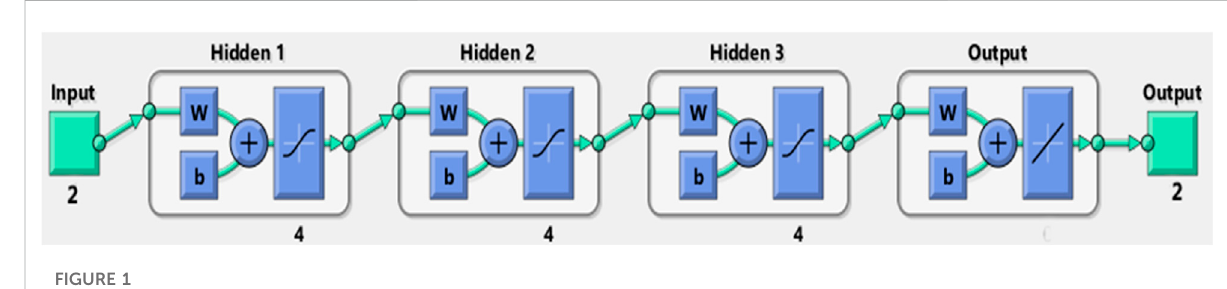
FIGURE 1 Designed deep learning neural